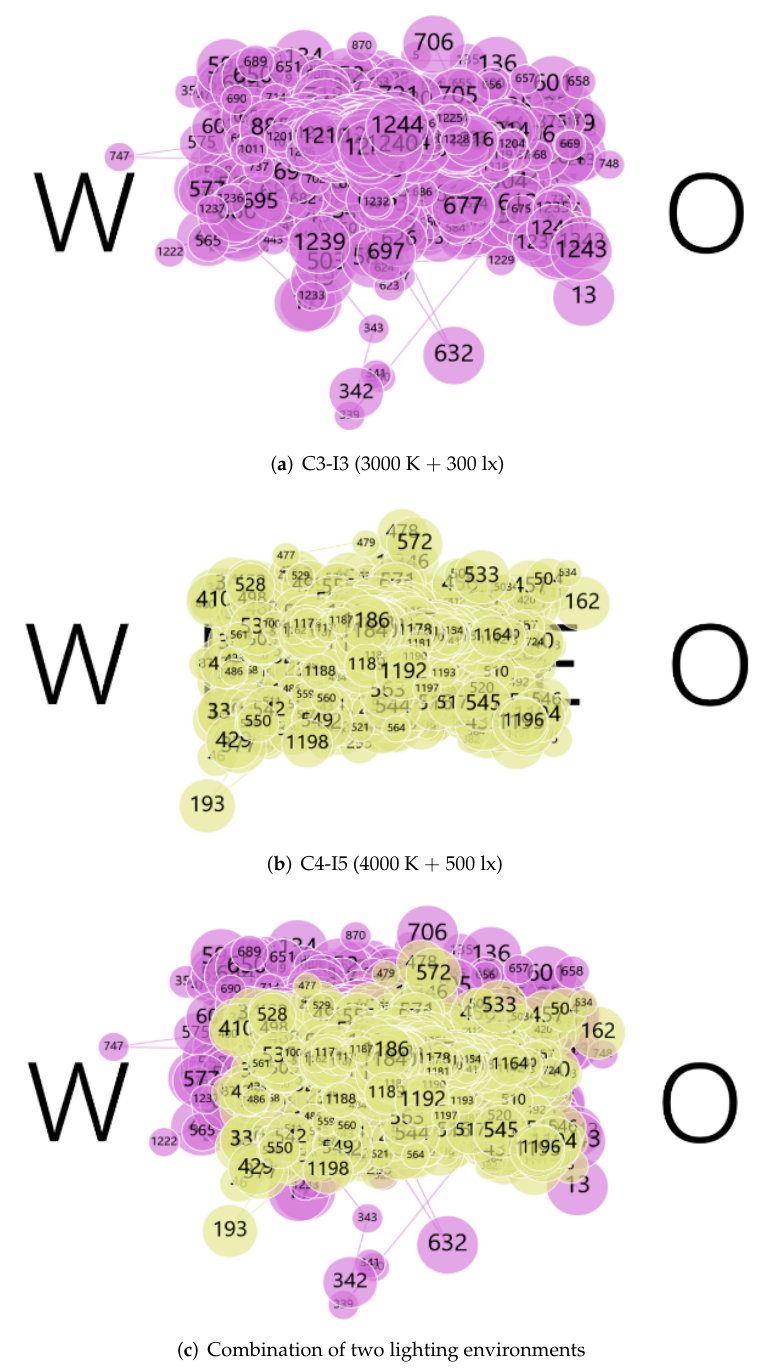
Figure 11. Fixation point trajectory diagram for test 1 under different lighting